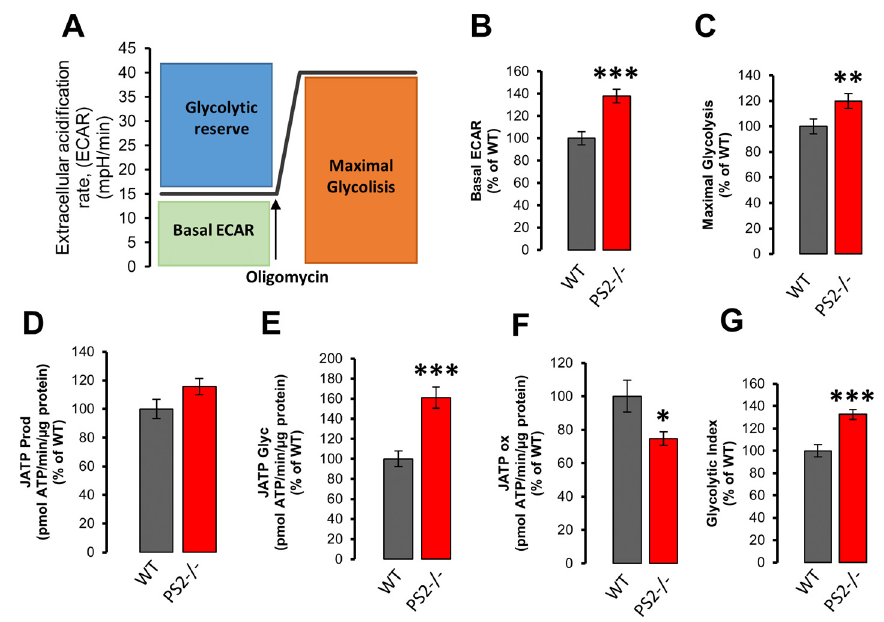
Figure 6. The lack of PS2 induces a metabolic switch towards glycolysis. ( A ) Extracellular acidifica- tion rate (ECAR) experimental protocol. ( B – E ) The bar graph shows the mean ± SEM, as a percentage of WT, obtained in WT (gray) or PS2–/– (red) cortical neurons of: ( B ) the basal ECAR, *** p < 0.001;